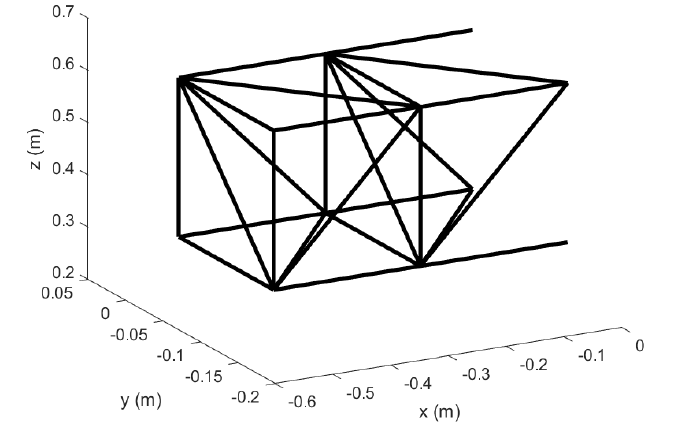
Figure 25. Un–morphed wing in Topology 1 with hinged ends; original